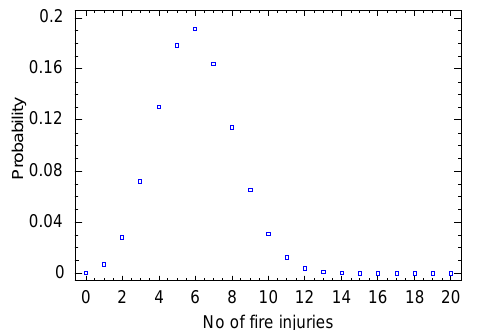
figure 3. probability mass function of the random number of injured persons,  a , fire scenario r = 2);  1